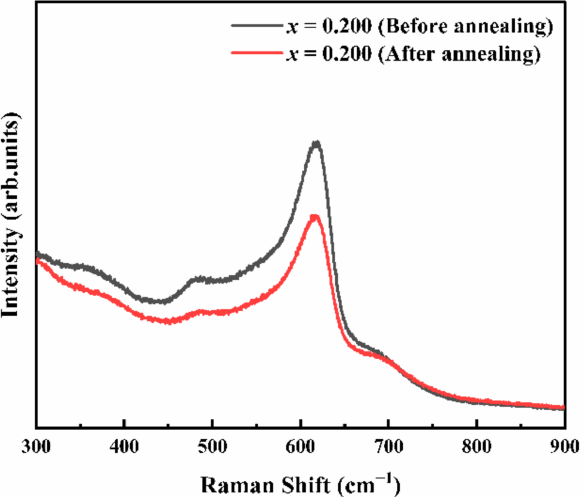
Figure 3. Raman spectra of (ZrO 2 ) 92 (Y 2 O 3 ) 7.800 (Tb 4 O 7 ) 0.200 crystals before and after annealing at 1500 ◦ C in a H 2 /Ar